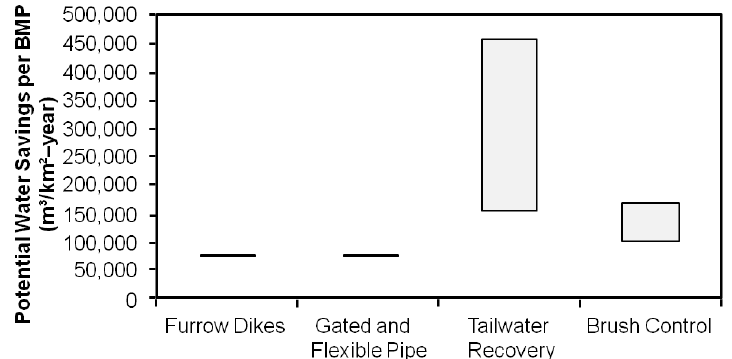
Figure 7. These four irrigation efficiency management practices vary in water savings potential per area covered with about 76,000 m 3 /km 2 possible per year from using furrow dikes and piping and up to 460,000 m 3 /km 2 possible per year from using tailwater recovery. (Source data: [37]).